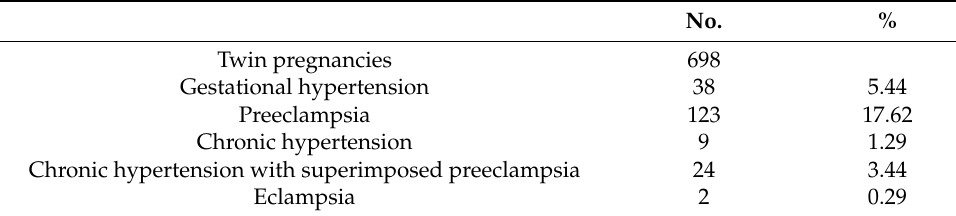
Table 1. Prevalence of twin pregnancies with hypertensive